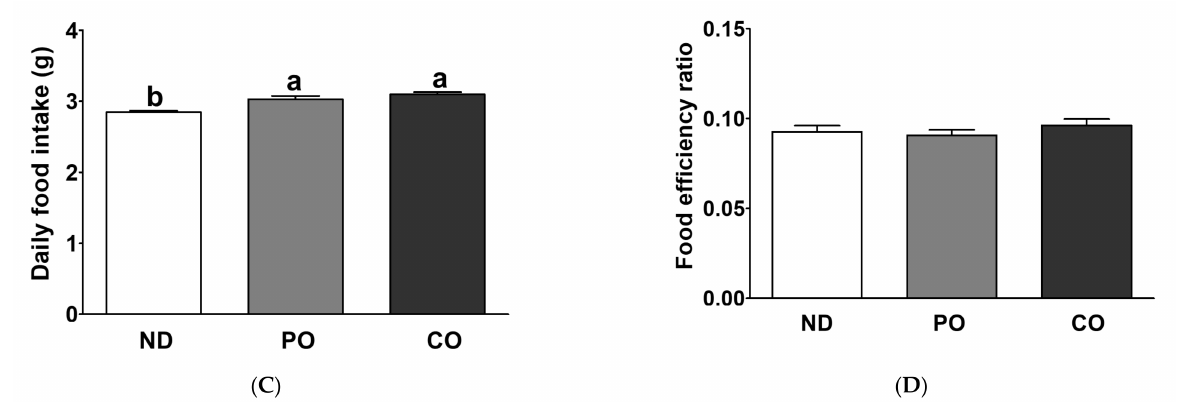
Figure 1. Partial replacement of dietary fat with PO or CO on body weight change, food intake, energy intake and food efficiency ratio in ob/ob mice. Mice were fed either an ND or an ND partially replaced with PO or CO for 12 weeks ( n = 16 per group). ( A ) Body weight changes; ( B ) body weight gain (final BW—initial BW); ( C ) daily food intake; ( D ) food efficiency ratio. Values are presented as the mean ± standard deviation. Data were analyzed using one-way ANOVA followed by Tukey’s post hoc test. *, ** and *** denotes a significant main effect of diet at p < 0.05, p < 0.01 and p < 0.001, respectively. Labeled means without a common letter differ ( p < 0.05). ND, normal diet; PO, perilla oil replacement; CO, corn oil replacement; BW, body weight.